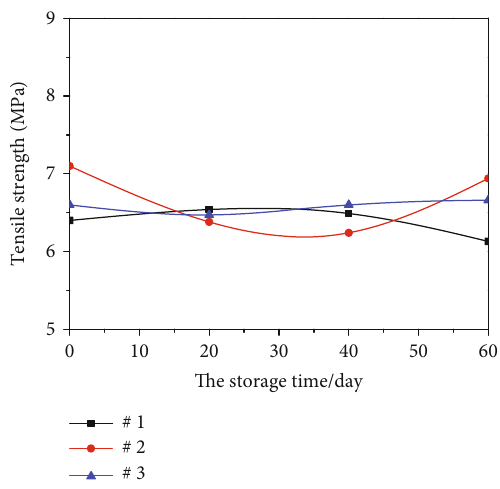
Figure 8: The tensile strength values of the reclaimed rubber vulcanizates revulcanized after storing for various storage periods. The tensile properties of the revulcanized reclaimed rubber were less a ff ected with storage time of the reclaimed rubber.